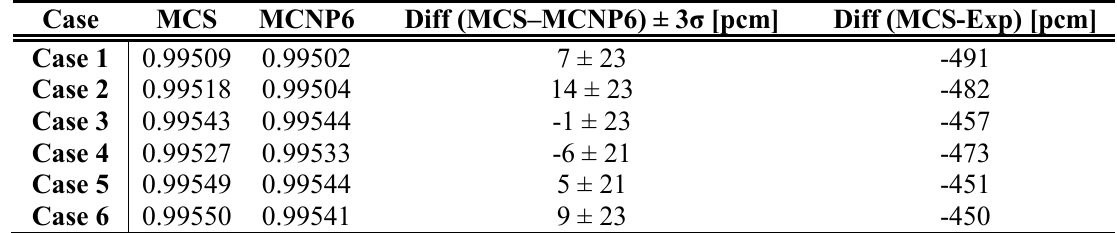
Table II. Comparison of k-eff between MCS, MCNP6 and experiment